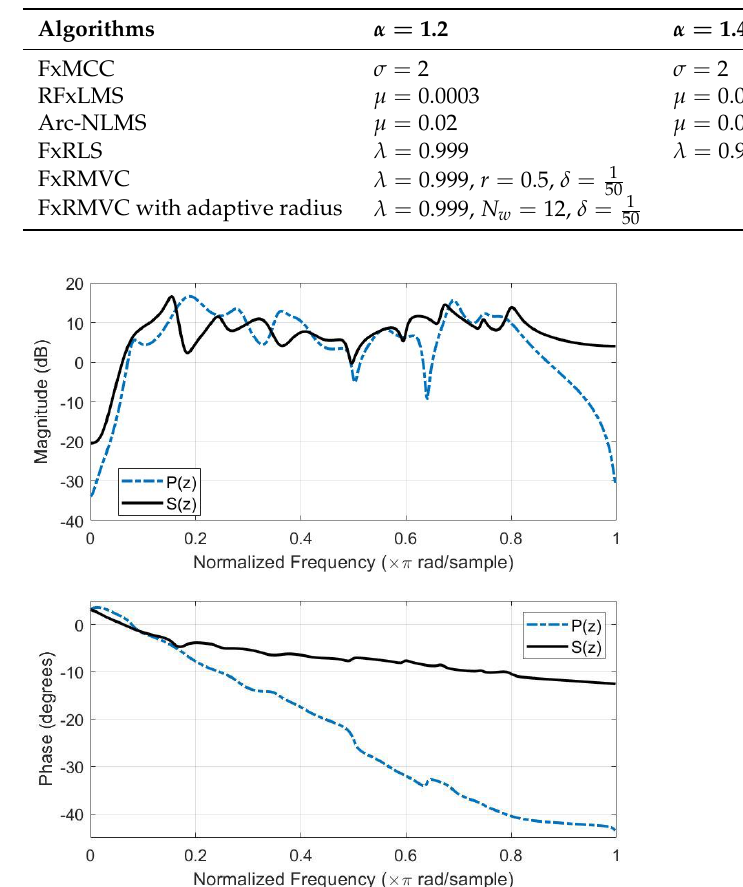
Figure 3. Magnitude and phase response of the acoustic